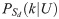
The sharing distribution as a function of the interaction parameter, PSd(k|U) {k = 0, 2, …, K} for K = 6 animals in N = 6 jars.(a) The probability of non-sharing (black solid line) is 7% for females (red dot at U = 0.82) and for males 67% (blue dot at U = 3.45). For neutral animals the probability of non-sharing is 1.5% (green dot at U = 0). (b) Comparison of the sharing probability for females (red), males (blue) and neutral animals (green). The empirical probability, obtained by averaging of 10 days, is also shown for females (magenta) and males (cyan).